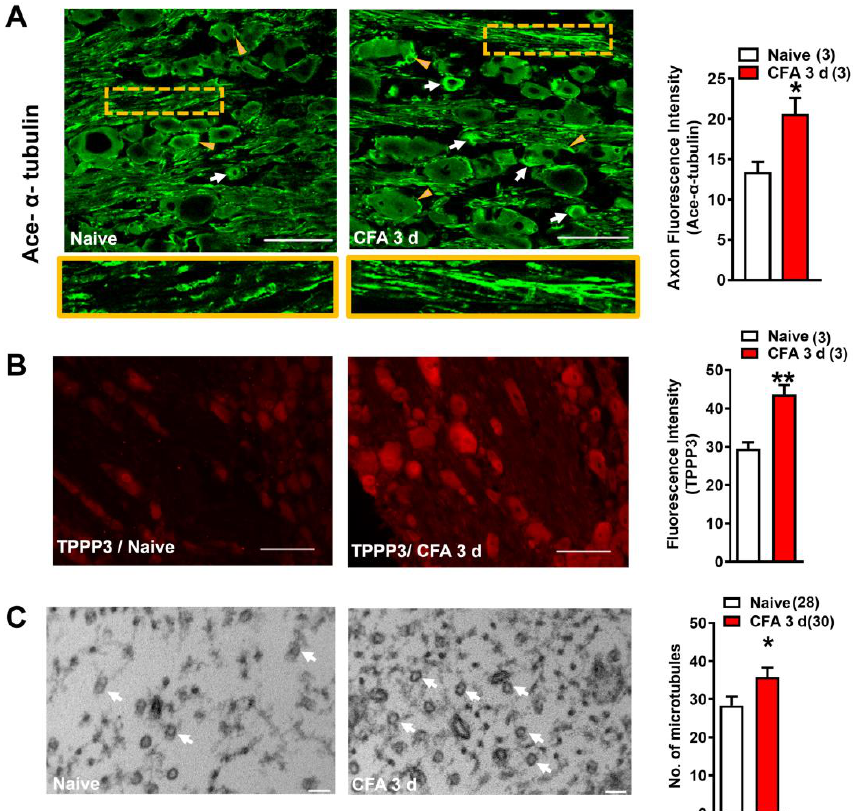
Figure 1. Polymerization of microtubules in rat DRG increased in the CFA-induced inflammatory pain. ( A ) Immunofluorescence staining showed a moderate increase of ace- α -tubulin in small-diameter DRG neurons at 3 d after CFA injection compared with that of the naïve (white arrows). While the ace- α -tubulin fluorescence intensity of axons showed a significant increase. The lower panel is the high magnification of the yellow boxed area in the upper panel. ( B ) The immunofluorescence staining demonstrated that the TPPP3 expression in DRG neurons at CFA 3 d was significantly increased compared with that of the naïve. ( C ) The number of microtubules examined by electronic microscopy significantly increased in unmyelinated or thin myelinated axons of DRG neurons at 3 d after CFA injection, compared with the naïve. All data were expressed as mean ± SEM ( n = 3, 3 in ( A , B ); n = 28, 30 in ( C )). Unpaired t -test, * p < 0.05, ** p < 0.01. Scale bar in ( A , B ): 100 µ m. Scale bar in ( C ): 50 nm. Three independent experiments were